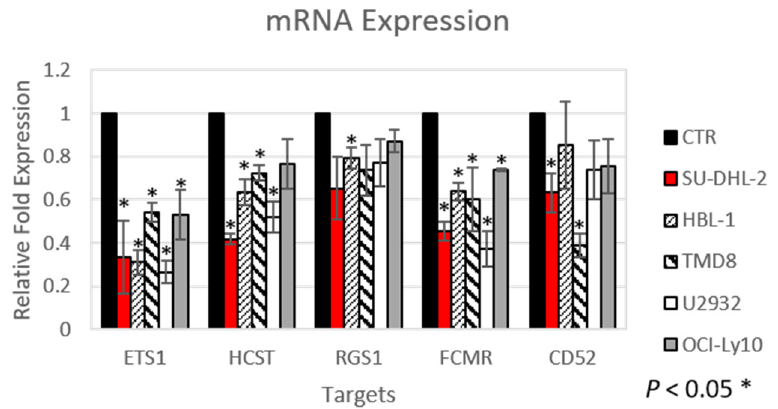
Figure 1. Knockdown of ETS1 reduces the expression of genes with important functions in normal B cells and DLBCL cells. A qRT-PCR was used to determine the expression of the indicated genes following knockdown of ETS1 by siRNA in five ABC-DLBCL cell lines. The expression of each gene was normalized to GAPDH expression. Results shown are the average of three independent experiments; n = 3; error bars = standard deviation. Asterisk above bars indicates significant difference in expression, p < 0.05.